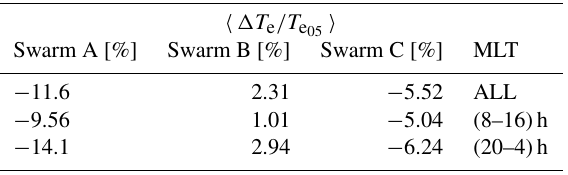
Table 3. Average relative difference between T e the Swarm spacecraft for different MLT ranges. The results are ob- tained considering 1 week of data from 7 to 13 September